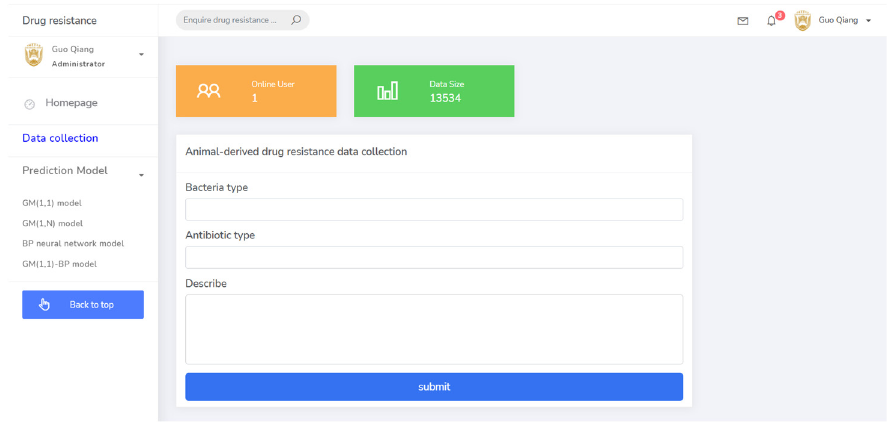
Figure 7. The data collection page of the system.